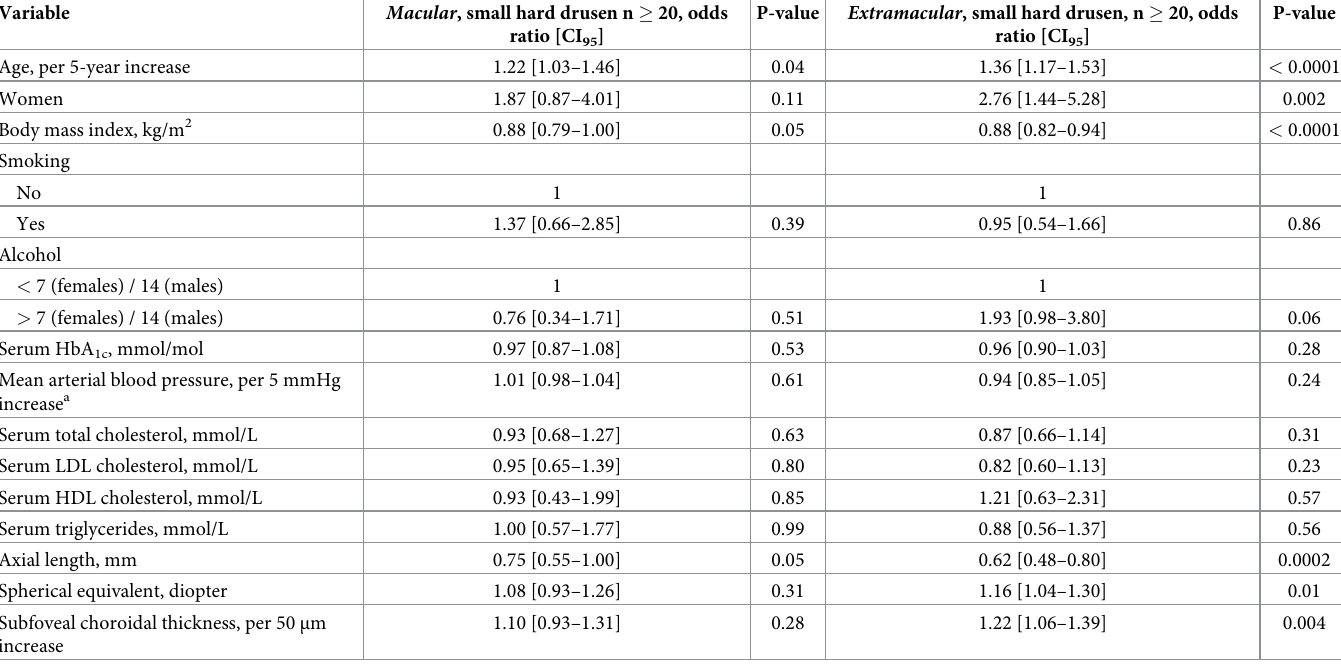
Comorbidity variables heart disease, respiratory disease, gastrointestinal disease and neurological disease were omitted due to too few cases. For continuous variables, odds ratio estimates have been calculated per one-unit increase unless otherwise indicated. An average of both eyes was used for spherical equivalent, axial length, and choroidal thickness estimates. a Participants diagnosed with hypertension have been